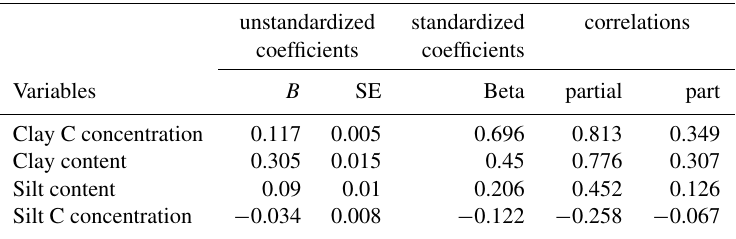
Figure 4. Across the transect, the concentrations and stocks of C (a, b) and N (c, d) in bulk soils were negatively correlated with the content of sand and positively correlated with the contents of silt and clay. Data are presented as mean ± 1SE ( n = 5). Table 3. Results of the multiple regressions refer to the final accepted model which just included the effects of the significant variables for C stocks in bulk soils of arid and semi-arid